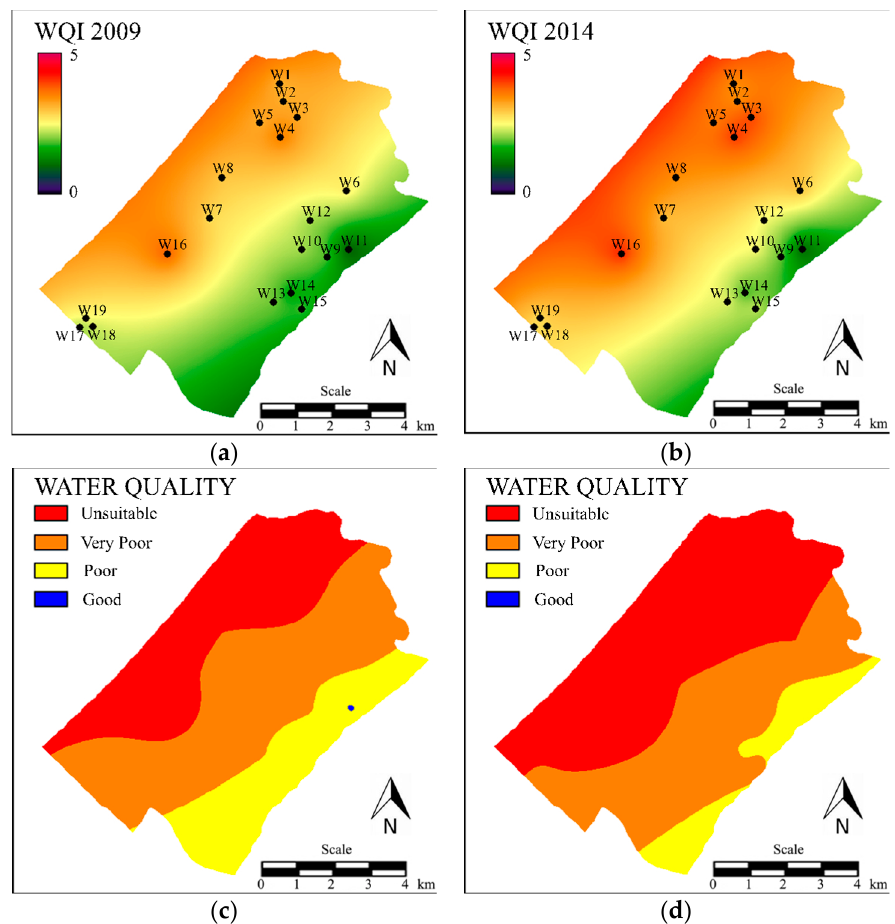
Figure 7. Maps with the spatial distribution of ( a ) WQI scores based on data from 2009, ( b ) WQI scores based on data from 2004, ( c ) groundwater quality classification for 2009 and ( d ) groundwater quality classification for 2014.